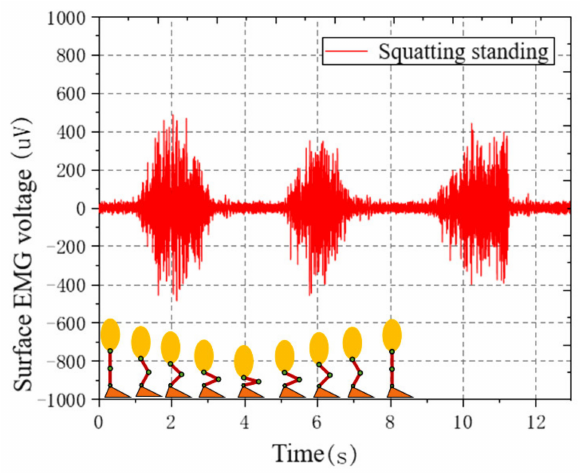
Figure 3. Surface electromyography of the rectus femoris in squatting-standing motion mode.